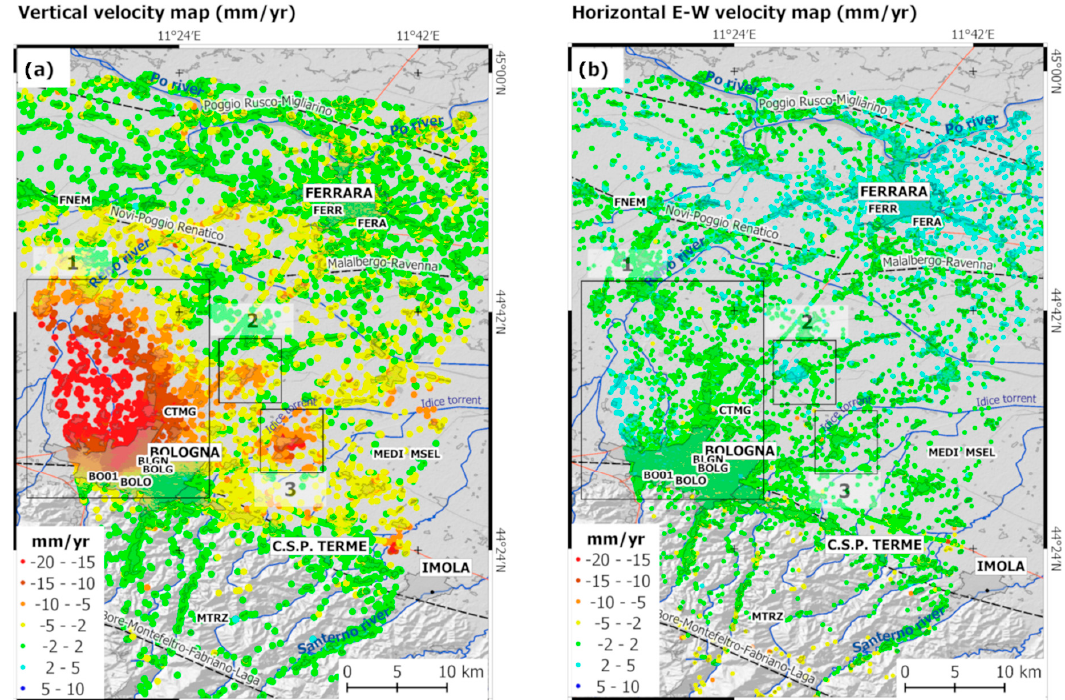
Figure 6. Velocity maps (mm/yr) oriented in the vertical (up) ( a ) and East-West ( b ) directions. Rectangles represent areas of interest, as in Figure 4. Negative rates in (a) indicate subsiding phenomena. Negative rates in (b) indicate West-oriented horizontal displacement, and positive rates indicate East-oriented horizontal displacement.